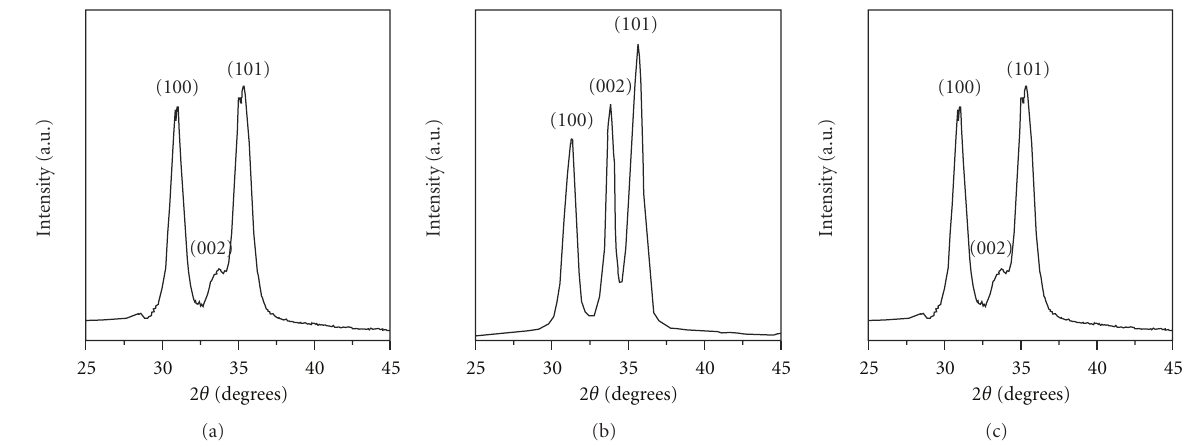
Figure 4: GIXRD patterns of sample A (a), sample B (b), and sample C